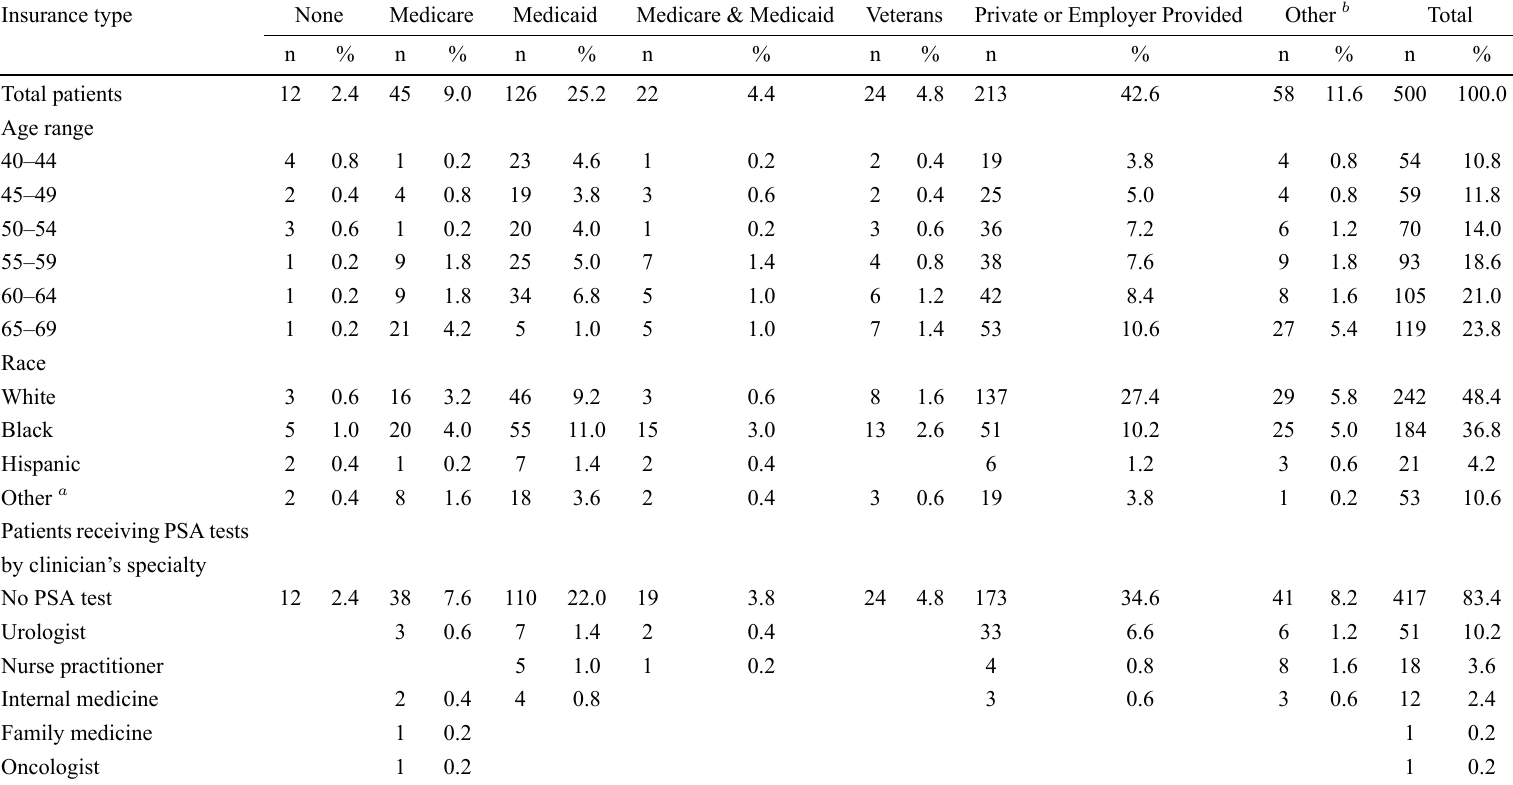
Table 2. Demographics of male patients by type of health